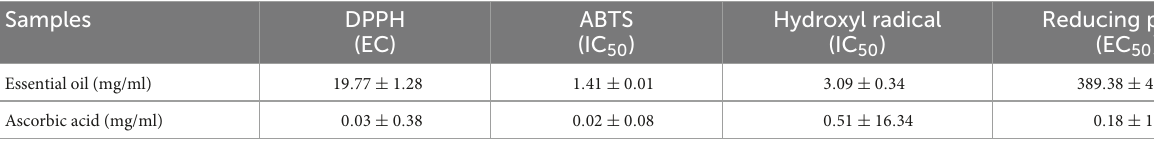
TABLE 2 Antioxidant capacity of the K. galanga essential oil measured by different assays. Samples